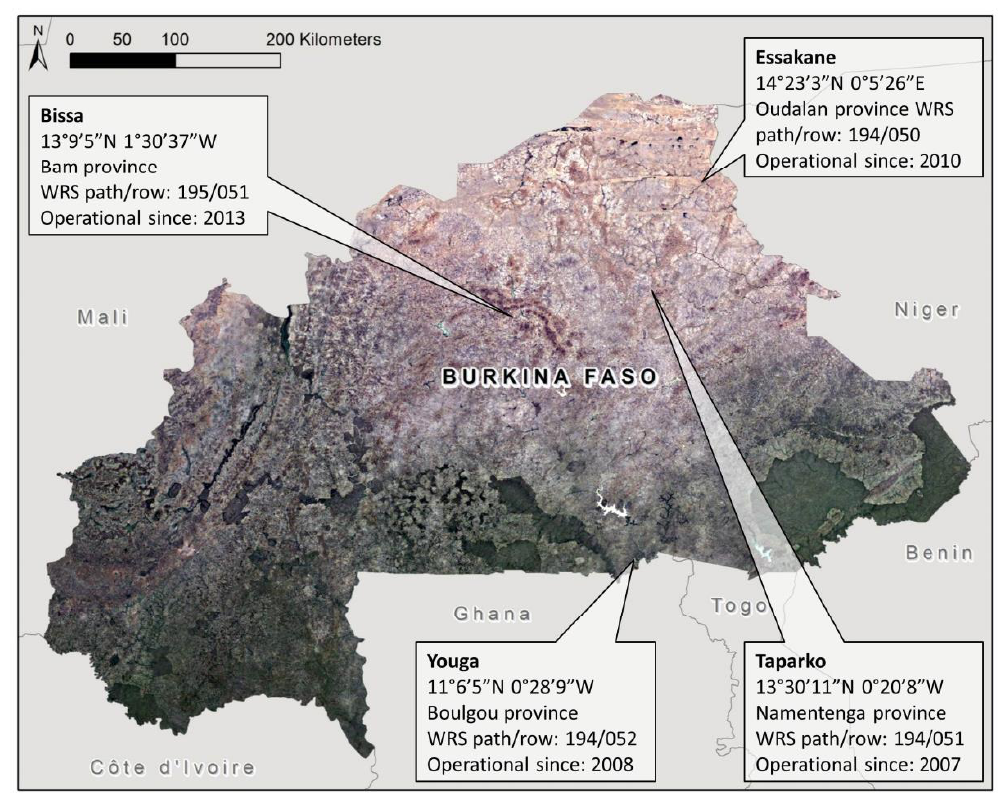
Figure 1. Location of gold mining areas included in this study.